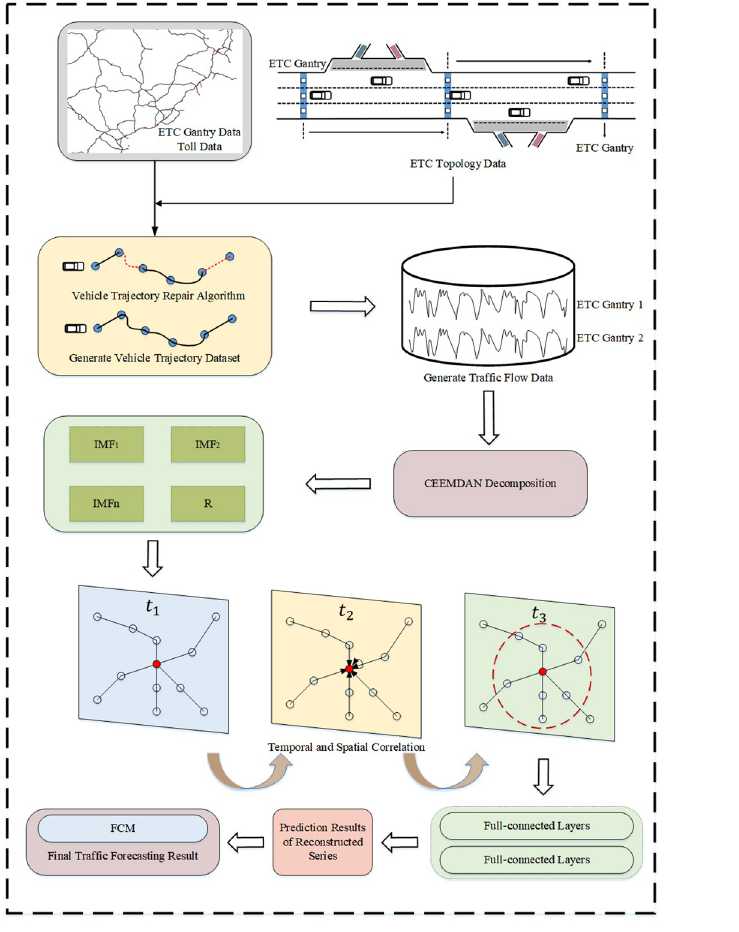
Fig 2. Summary of forecasting